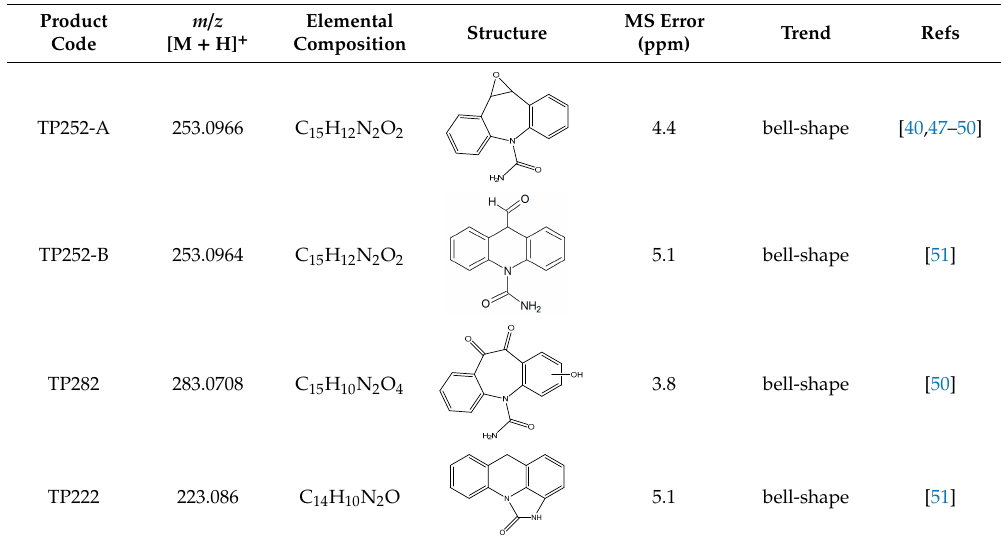
Table 3. Transformation products of carbamazepine (CBZ) by photolysis.